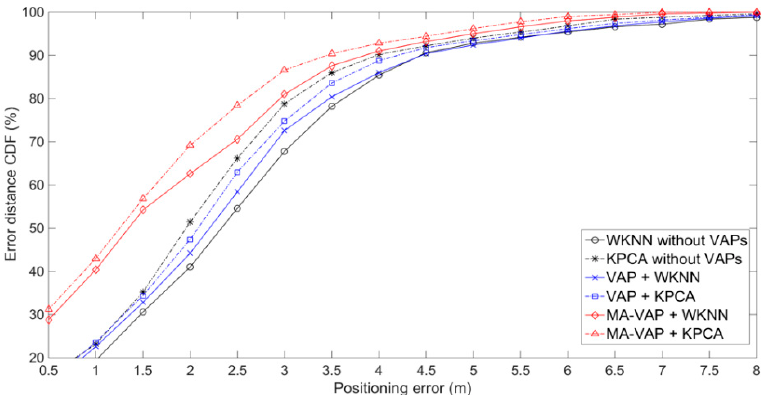
Figure 18. Comparison of the positioning results of different combination groups in experimental environment. Table 4. Positioning errors comparison of different combination groups at the 90% CDF in experimental